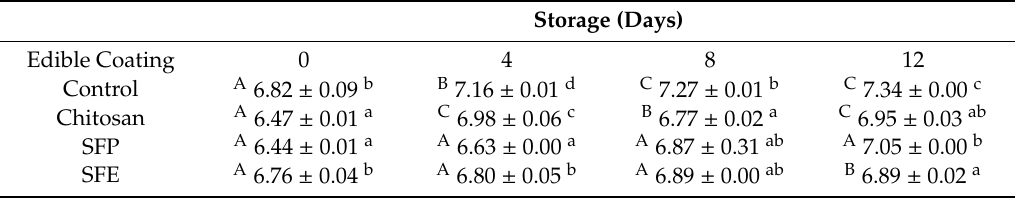
Values (mean ± standard deviation, n = 3) followed by a di ff erent uppercase letter in the same row are significantly di ff erent ( p < 0.05). Values (mean ± standard deviation, n = 3) followed by a di ff erent lowercase letter in the same column are significantly di ff erent ( p < 0.05).